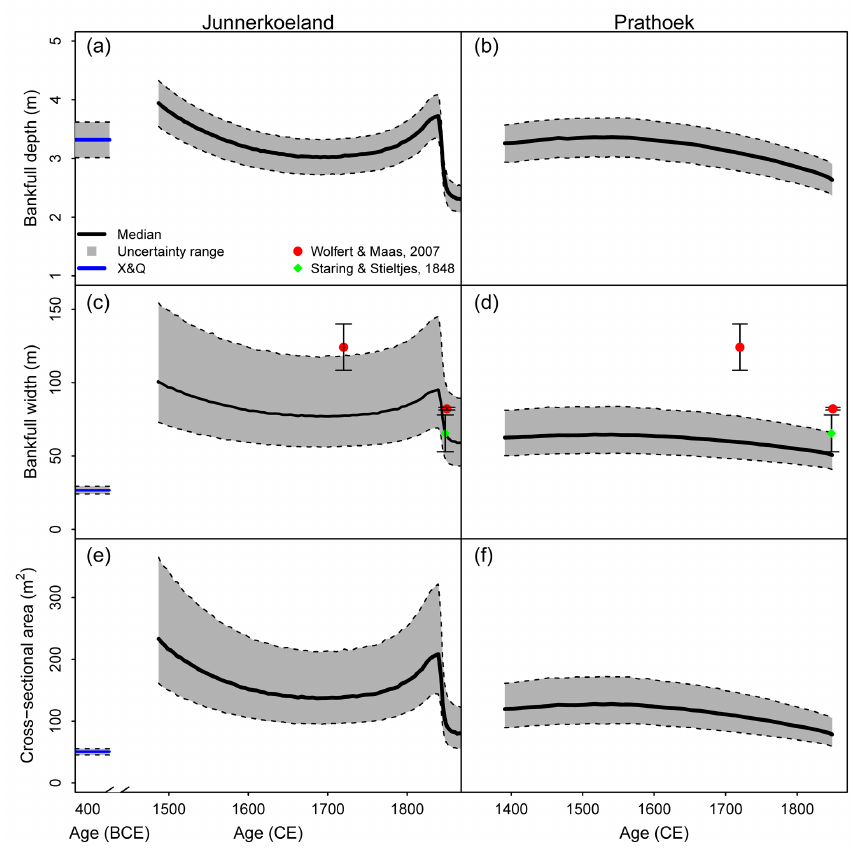
Figure 8. Reconstructed meander and channel geometry over time, assuming the date–distance relations (see Fig. 7c, d) over the scroll bars. Panels (a) and (b) show the bankfull depth ( H bf ) derived from the coring data taken from the bottom of the channel lag to the inferred bankfull water surface (Fig. 4c, d), for both the Junnerkoeland (a, c, e) and Prathoek (b, d, f) . Panels (c) and (d) show the bankfull width derived from the bankfull depth and reconstructed transverse bed slope (Eq. 1). The river width data from Wolfert and Maas (2007) observed on historical maps and the bankfull river width data from Staring and Stieltjes (1848) were included for comparison. Panels (e) and (f) show the cross-sectional area derived from the bankfull width and water depth (Eq. 2). Shading indicates the 16th and 84th quantile. X & Q refers to Palaeochannels X and Q